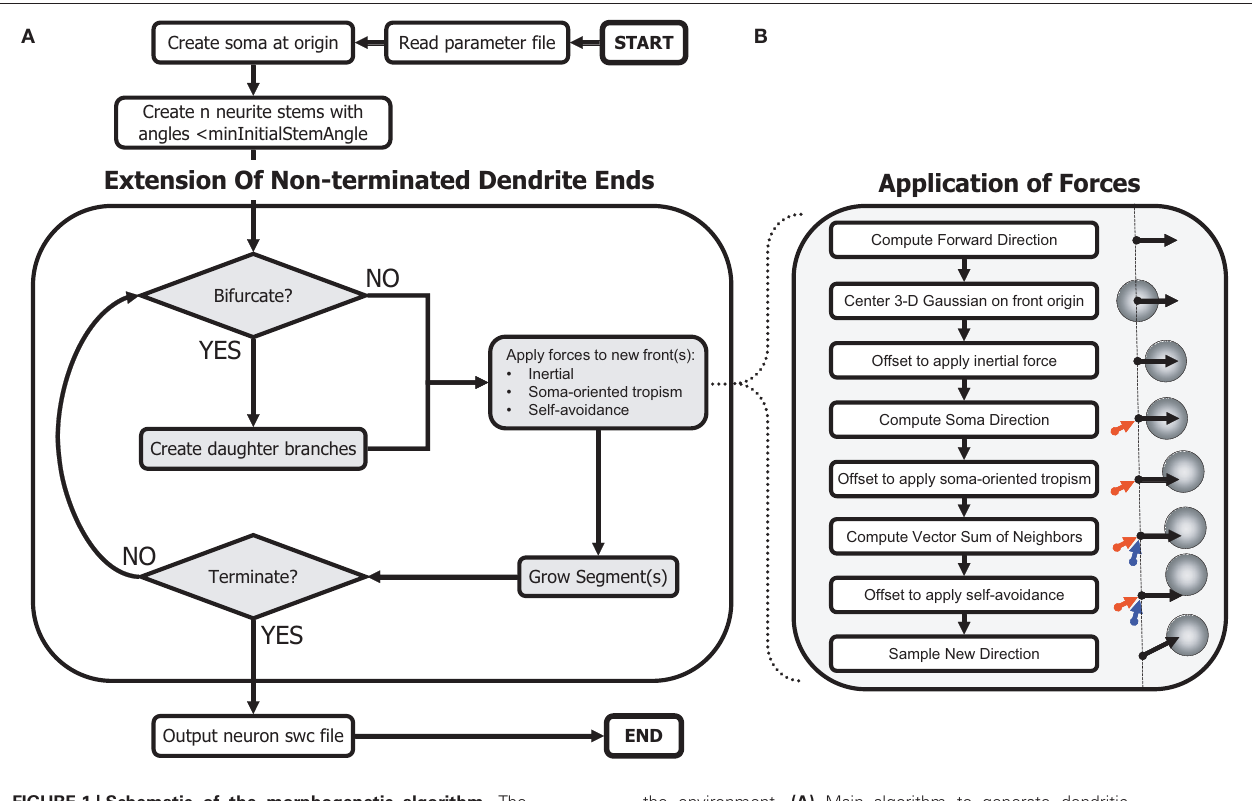
FIGURE 1 | Schematic of the morphogenetic algorithm. The phenomenological algorithm relies on a Galton–Watson process to create a topology while the geometry results from applied forces from